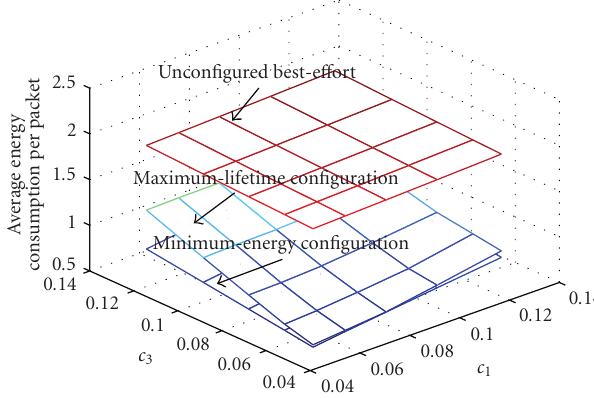
Figure 1: Average power consumption per packet with the maximum-lifetime configuration, minimum-energy configuration, and unconfigured best-e ff ort strategies ( P req = 0 . 95, N = 11, p = 0 . 56 max